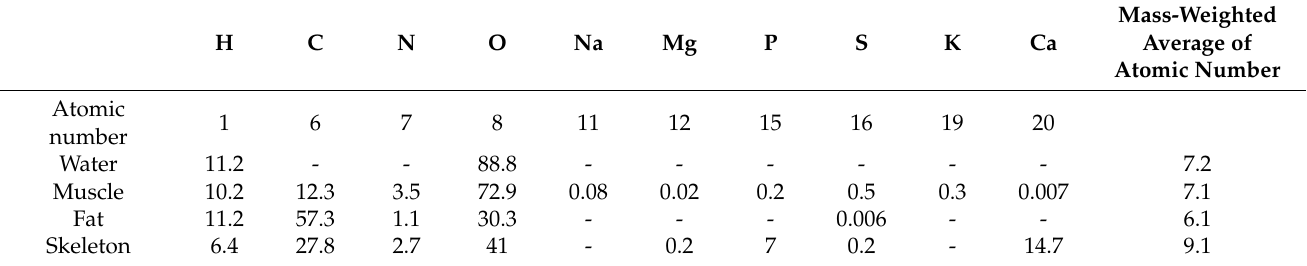
Table 2. Element proportions of biological tissue calculated by mass